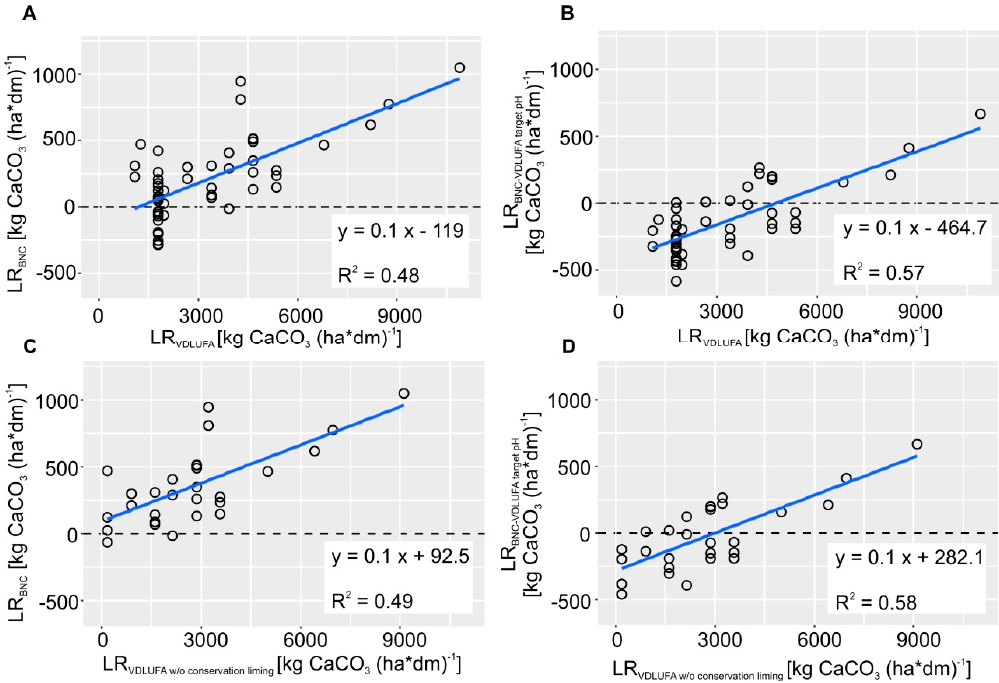
Figure 5. ( A ) Comparison between the LR VDLUFA and the LR BNC for a fixed target pH of 6.5, ( B ) the LR VDLUFA and LR BNC calculated for variable target pH values according to the VDLUFA, ( C ) the LR VDLUFA without conservation liming and LR BNC for a fixed target pH of 6.5, and ( D ) the LR VDLUFA without conservation liming and LR BNC calculated for variable target pH values according to the VDLUFA.